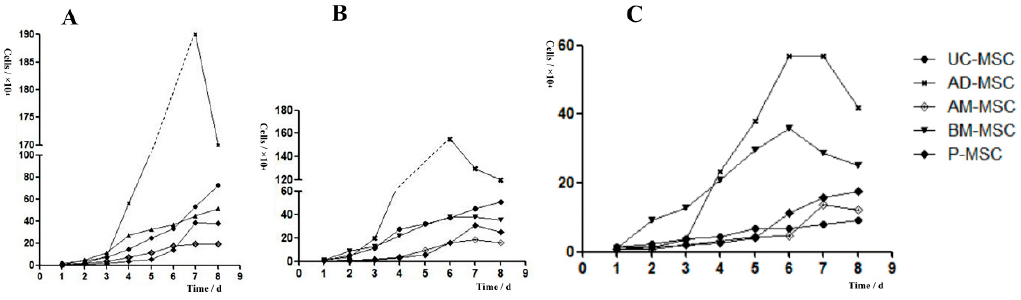
Figure 2. The growth curves of MSCs: ( A ) third generation, ( B ) sixth generation, and ( C ) ninth generation.